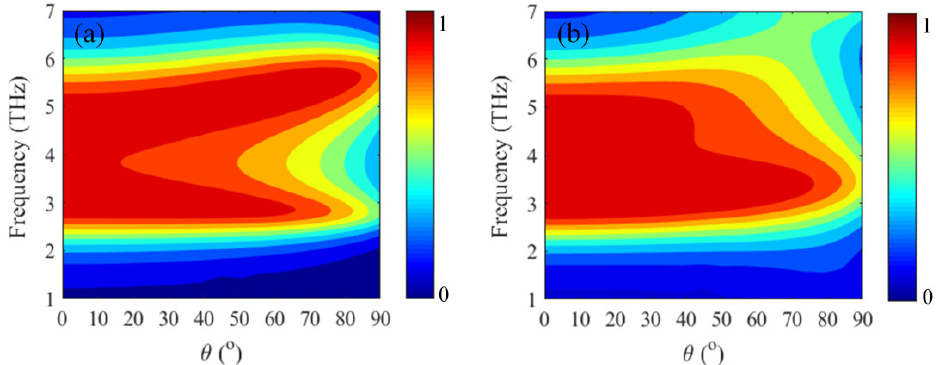
Figure 10. Absorption spectra with various incident angles for ( a ) transverse electric (TE) polarization and ( b ) transverse magnetic (TM) polarization.